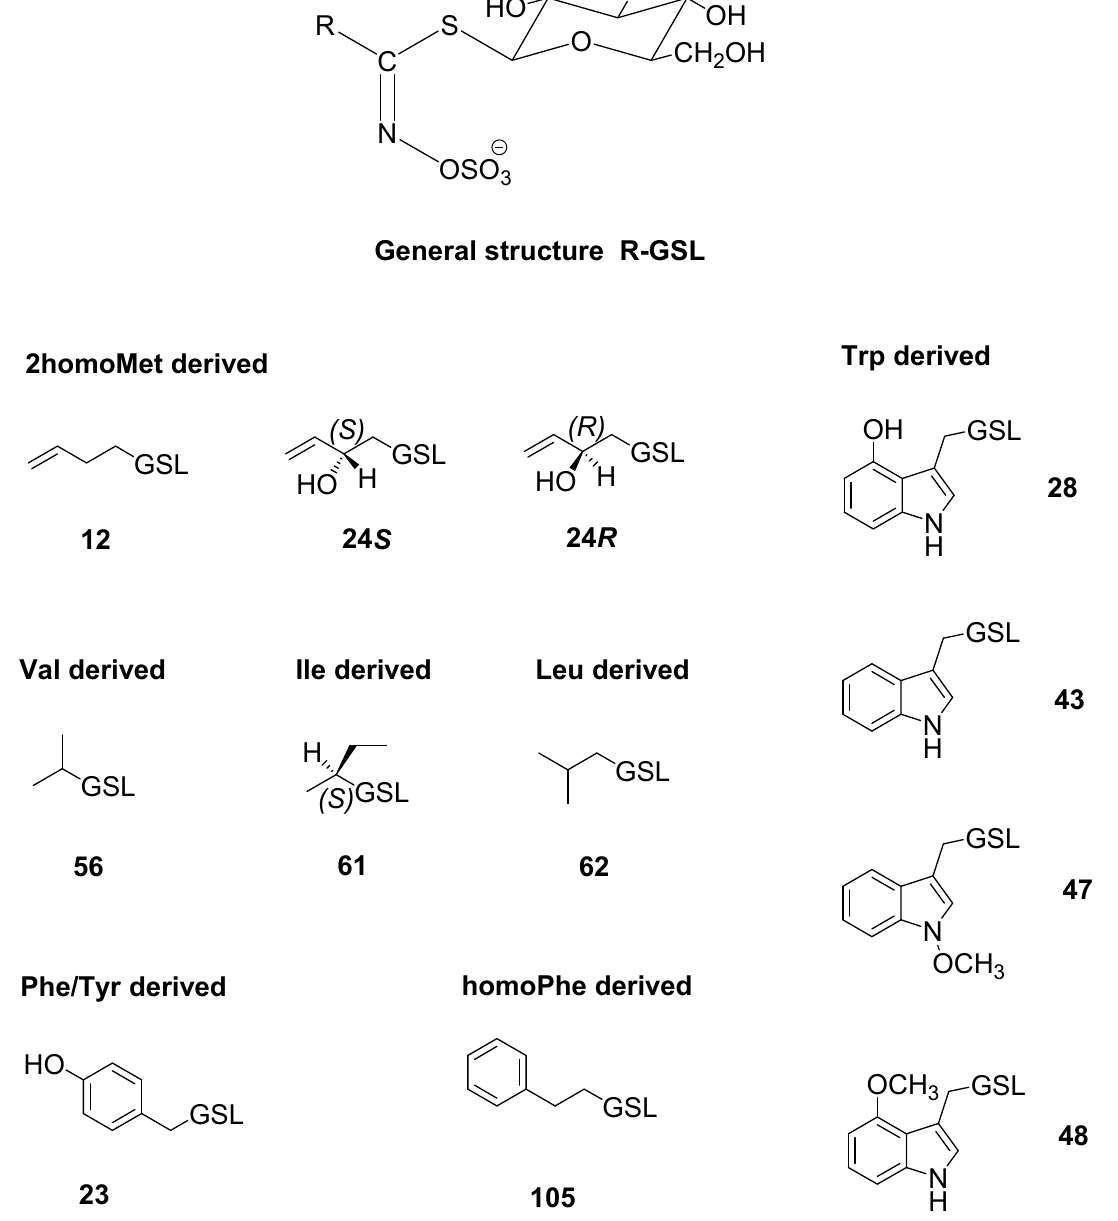
Figure 1. Structures of the GSLs identified in the investigated Sisymbrium sp. ( cf . Tables 1–3). Table 1. Glucosinolate (GSL) content in diverse Sisymbrium officinal e plant parts collected from dif- ferent locations.